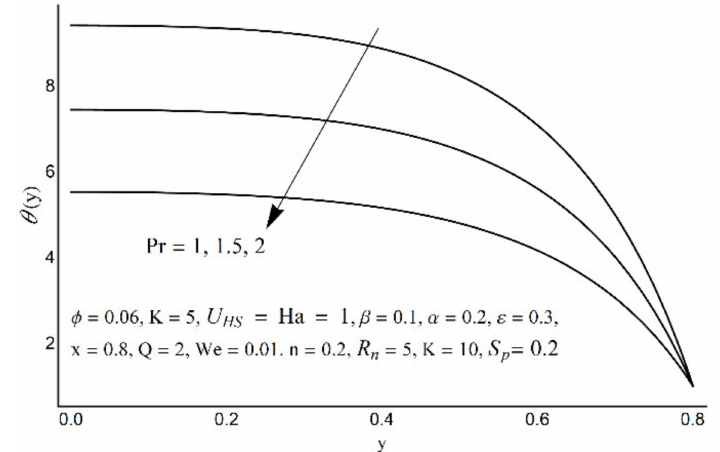
Figure 11. Temperature profile at various Pr.